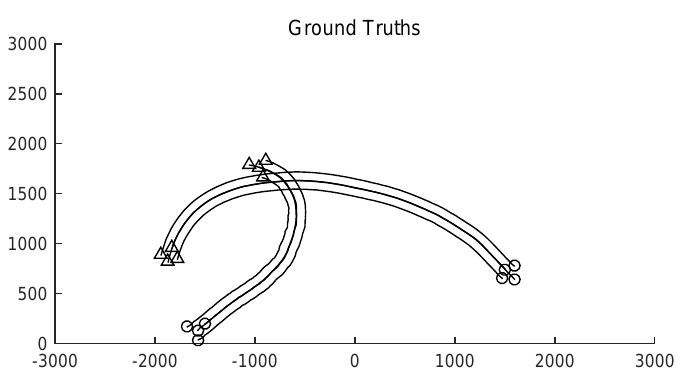
Figure 5. The tracks of group targets.